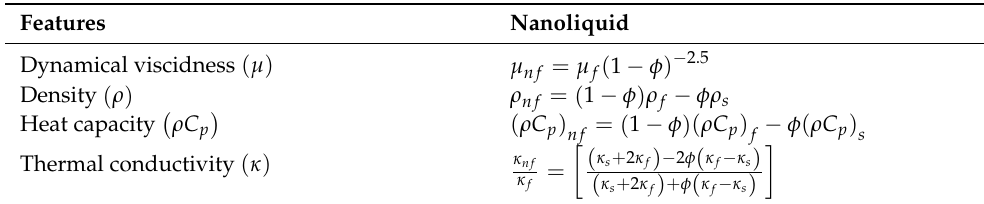
Table 1. Thermophysical properties for Powell-Eyring Nanofluid [29,30]. Features